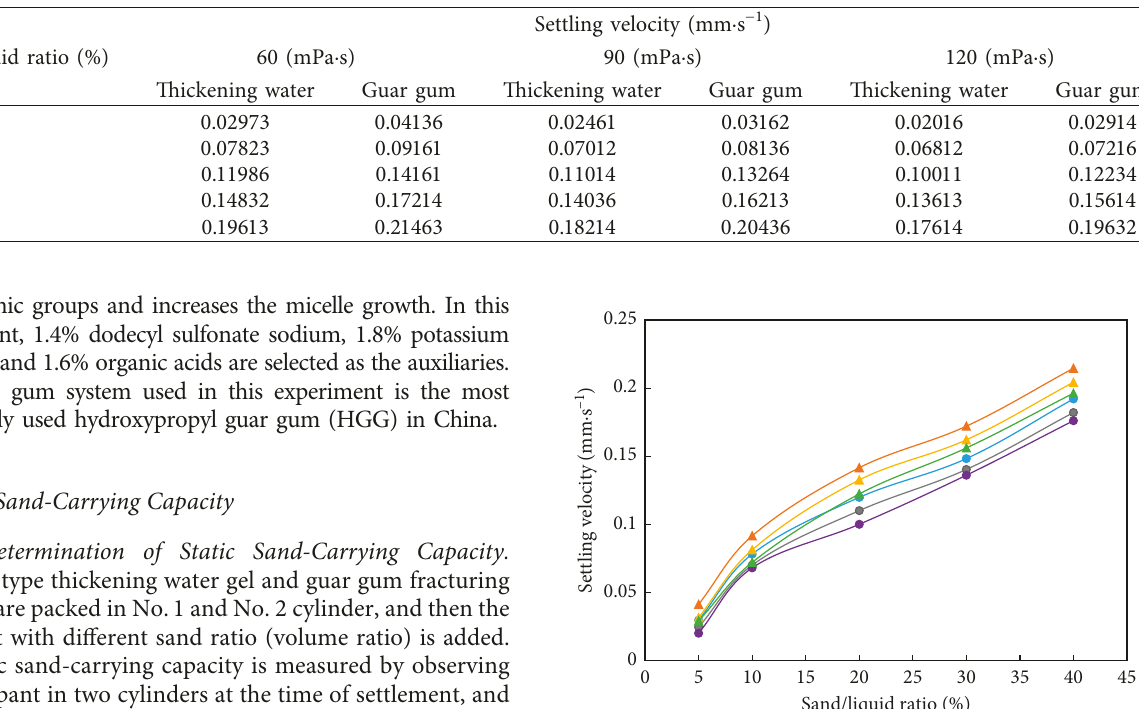
Figure 1: Schematic diagram of the mechanism of thickening water. T ABLE 1: Comparison of static sand-carrying capacity of two kinds of fracturing fluids.